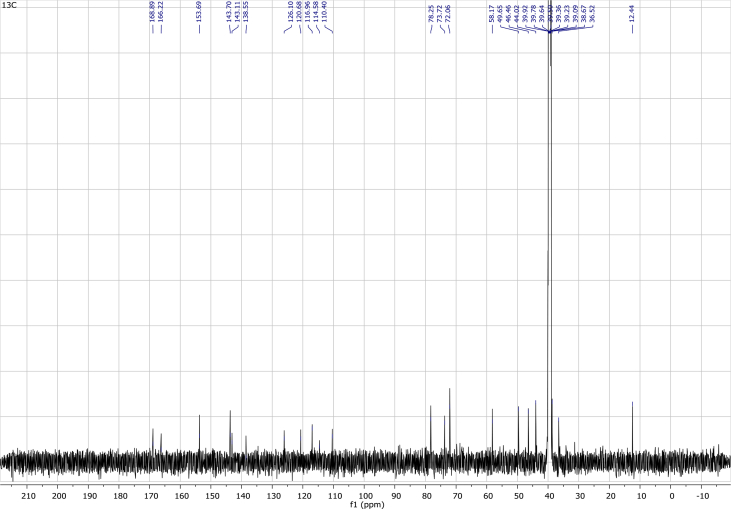
13C NMR (DMSO-d6) spectrum of compound 13.